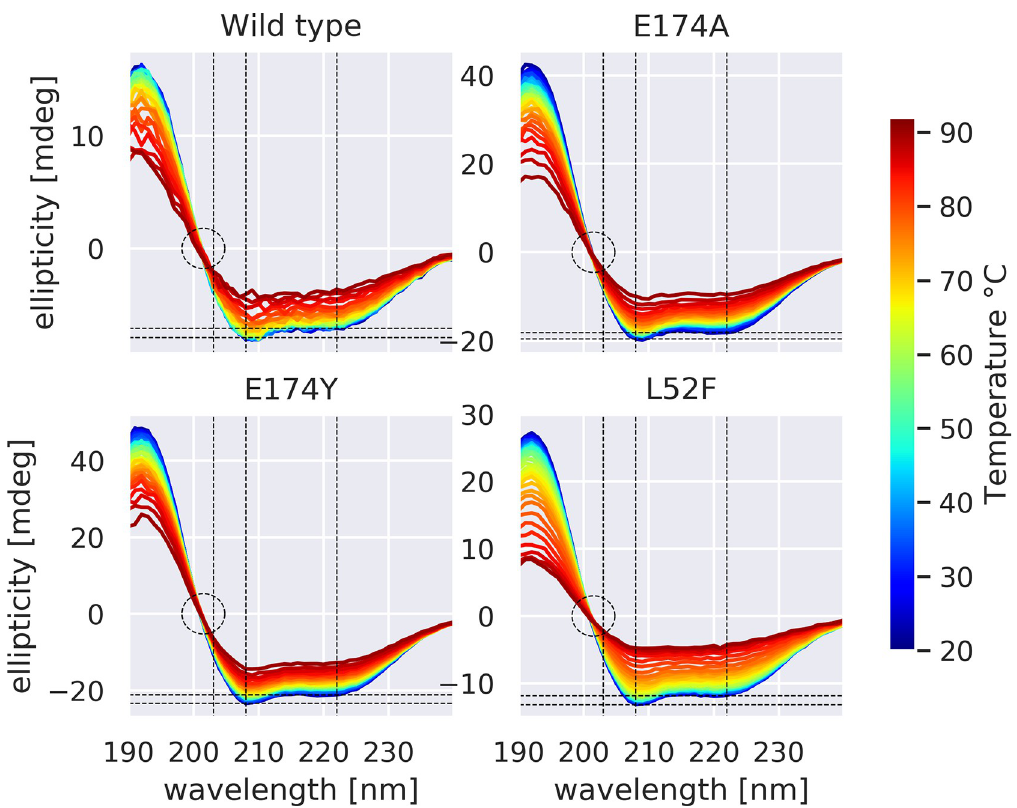
Fig 2. Circular Dichroism spectra for WT and three rhGH variants, observed at temperatures from 20 to 92C. Note the presence of clear isodichroic points at 201.5 nm (circled), indicating only α -helical and random-coil content (no β sheets), [14] consistent with crystallographic data (note this is clearly below 203 nm). The maximum at 190 nm and minima at 208 and 222 nm likewise indicate alpha helices. Higher ratio of ellipticity at 222 vs 208 nm ( θ 222/ θ 208) has been associated with coiled-coil content [15–17].Dashed vertical lines indicate 203, 209, and 222nm. Dashed horizontal lines indicate the ellipticity at these two wavelengths and 20C –the smaller relative gap for E174A (compared to WT, E174Y, and L52F) is visually apparent. The isodichroic point (zero crossing) indicates the protein is two-state, coil and helix [18]; our isodichroic point is near the 201.5nm reported by [19], rather than the 203-205nm reported elsewhere [18].